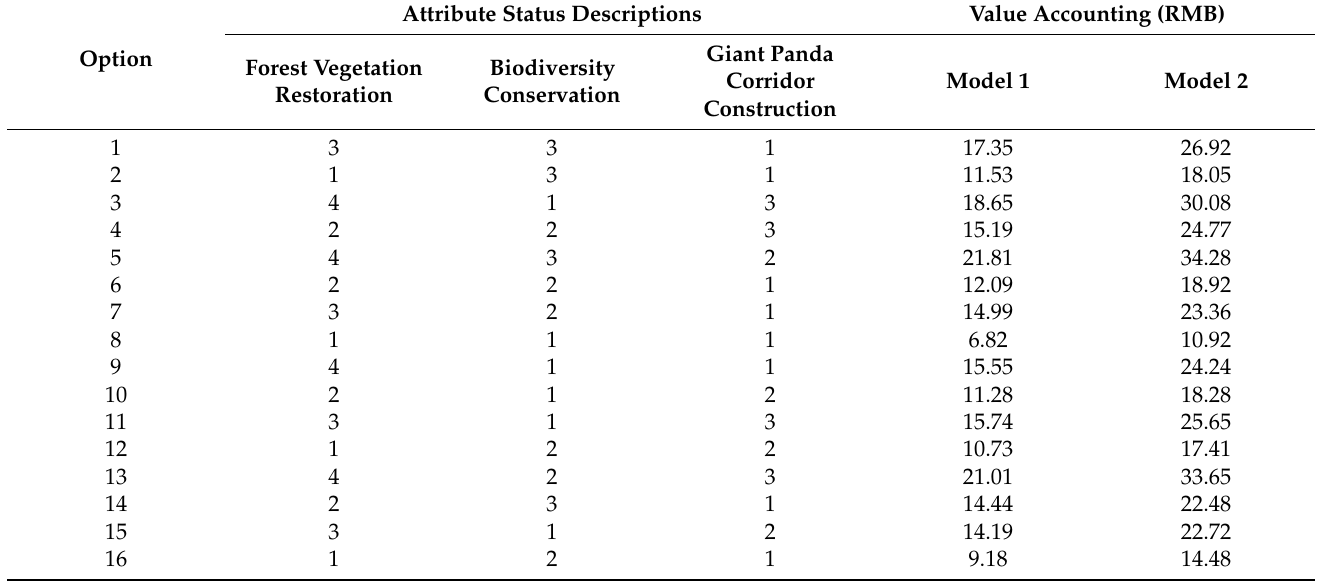
Table 5. Value accounting results of all choice options of ecological